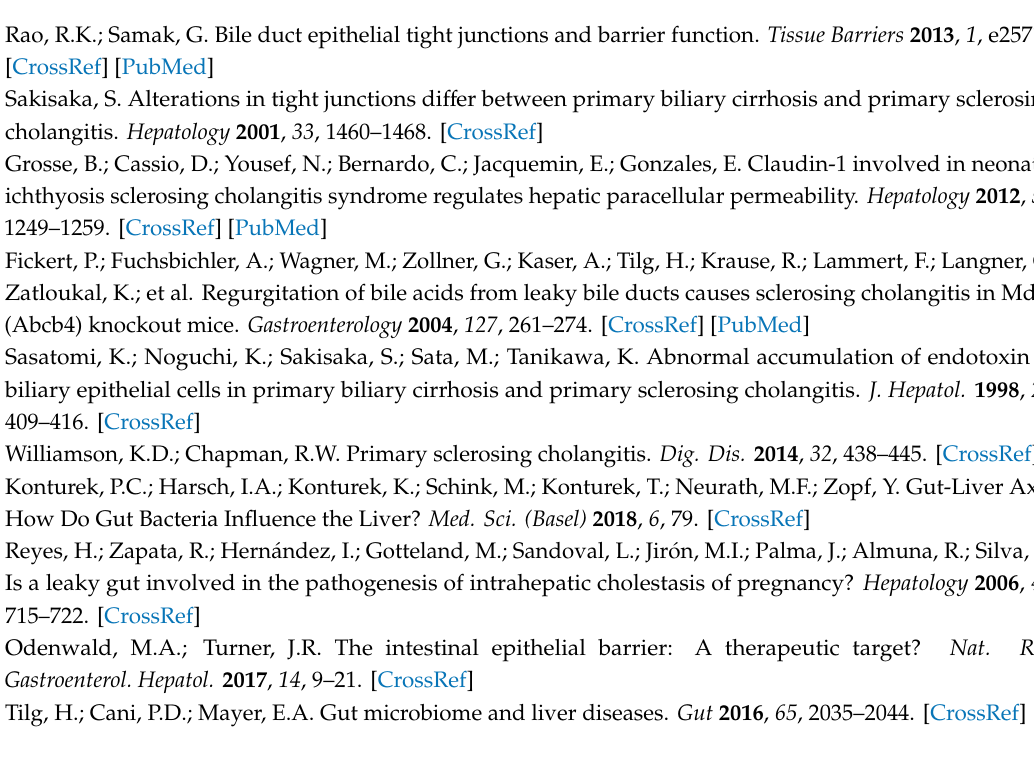
Figure S1: Serum alkaline phosphatase levels. Figure S2: Expression of genes responsible for BA synthesis and –transport, Figure S3: IL-13 knockout reduced ER stress, Figure S4: Epithelial proliferation and lymphocyte infiltration, Figure S5: Bacterial translocation to the liver was reduced in Abcb4 − / − / IL-13 − / − -mice. Figure S6: Graphical